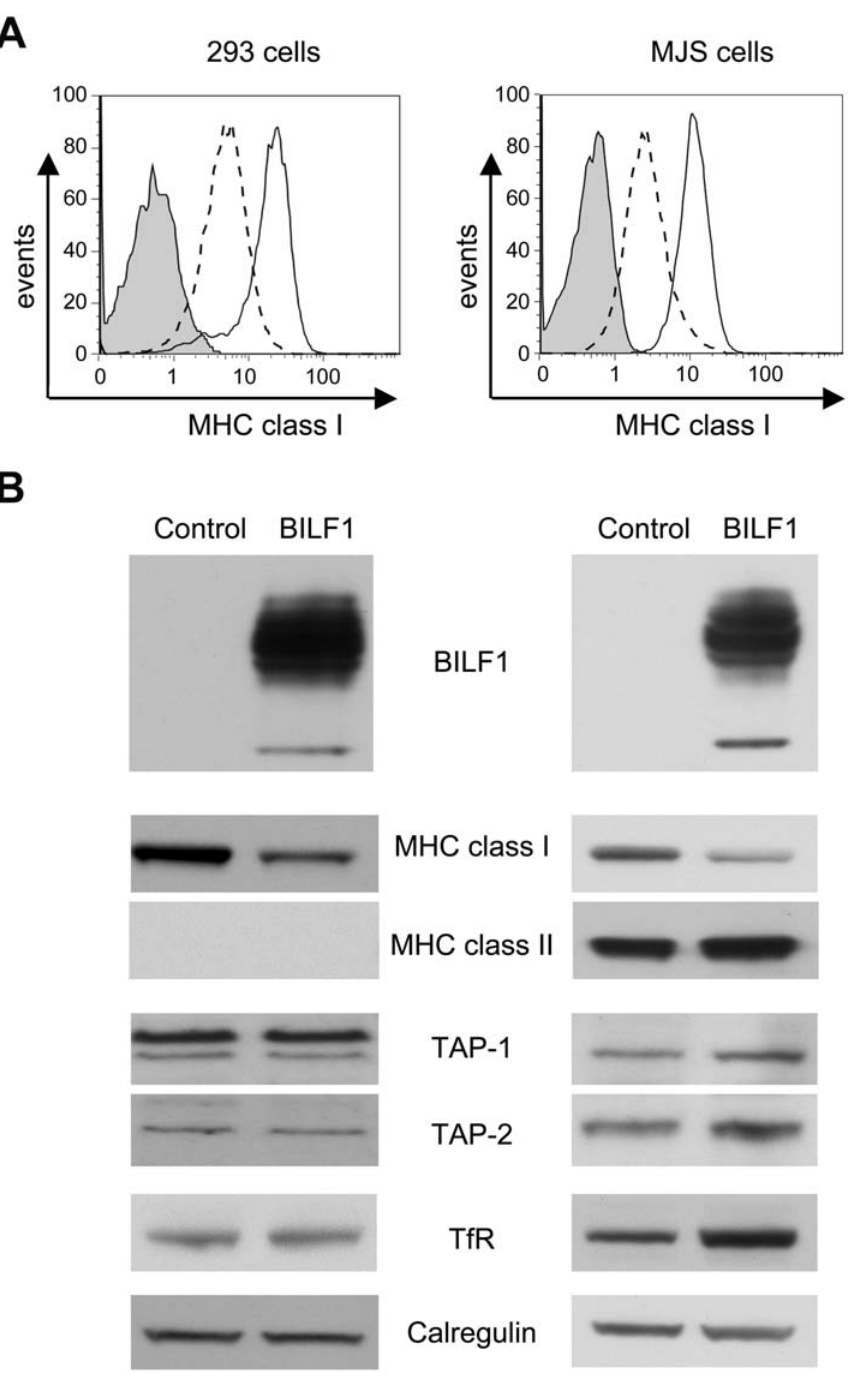
Figure 2. Characterization of cells stably transduced with a BILF1 retroviral vector. ( A ) 293 or MJS cells were stably transduced with control (pQCXIH) or BILF1 (pQCXIH-HABILF1) retrovirus. Surface MHC class I molecules were stained with PE-conjugated W6/32 antibodies and analyzed by flow cytometry. The solid line histograms depict the surface HLA class I staining of control cell lines, while the dashed line histogram depicts the surface HLA class I staining of cell lines expressing BILF1. The grey histogram illustrates background staining obtained with an isotype control PE-conjugated antibody. ( B ) Total cell lysates were generated from the retrovirus-transduced 293 and MJS cell lines, and 2 6 10 5 cell equivalents were separated by SDS-PAGE and analyzed by Western Blotting with mAbs specific for BILF1 (3F10, anti-HA tag), MHC class I (HC10), MHC class II (DA6.147), TAP-1 (148.3), TAP-2 (435.3), TfR (H68.4) or with polyclonal antibodies to calregulin as a loading control. doi:10.1371/journal.ppat.1000255.g002 EBNA3A, HLA-B35 restricted; and LMP2A, HLA-A2 restricted) HLA-DR4 restricted CD4 + effectors was not significantly different all recognized the BILF1-expressing LCLs less efficiently than the between the control and BILF1-expressing LCLs (Fig. 4B). Similar control LCLs. In contrast, recognition of BHRF1 antigen by results were obtained in 3 separate experiments.